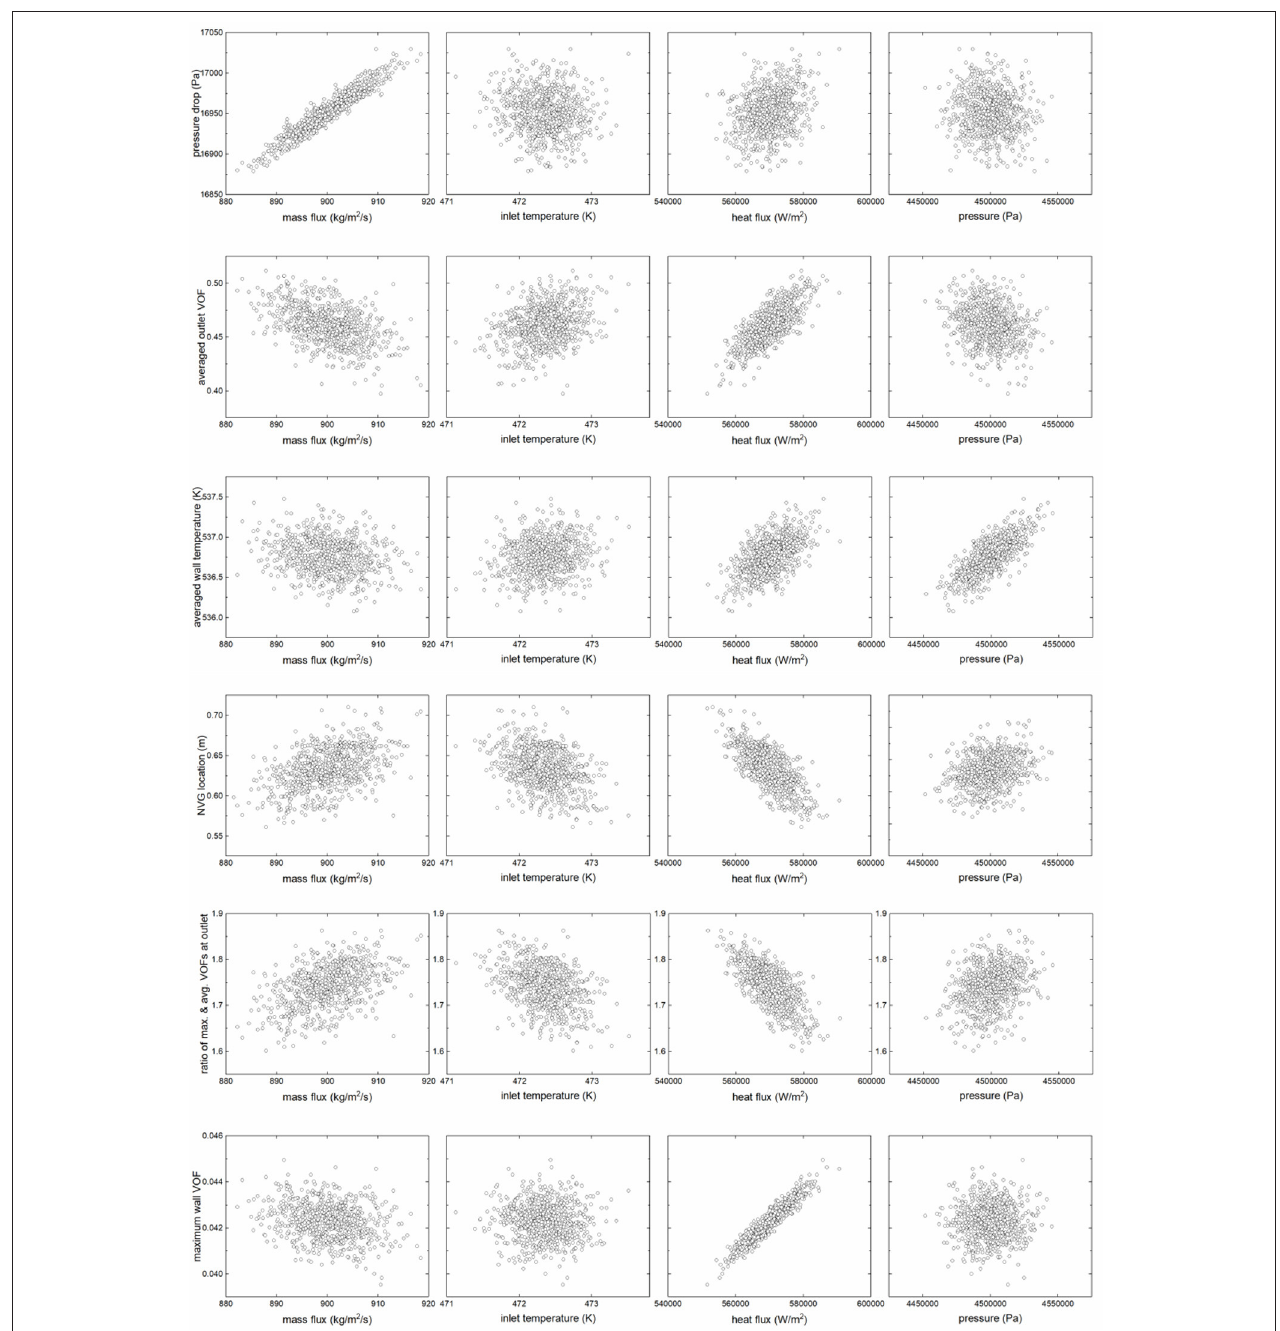
FIGURE 6 | Scatter plots between the boundary conditions and